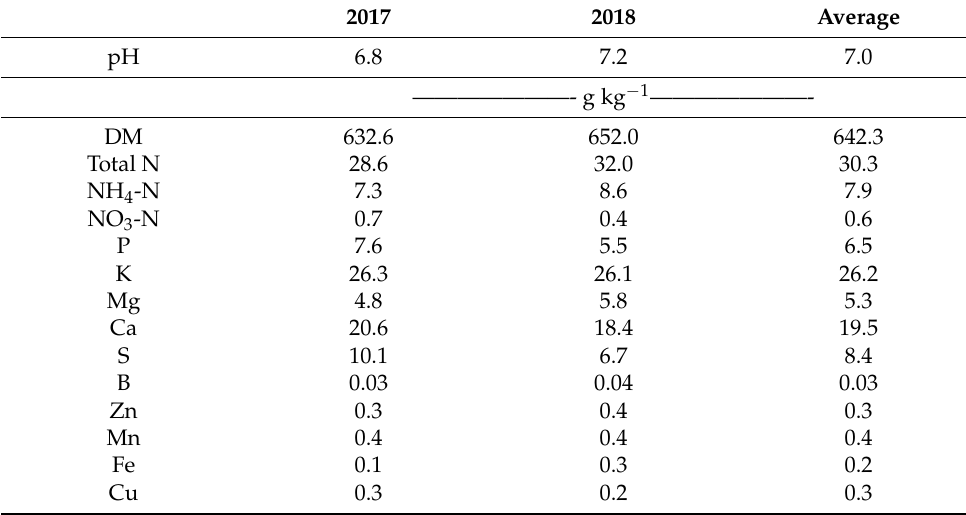
Table 1. Composition (wet basis) of broiler litter applied in 2017 and 2018.